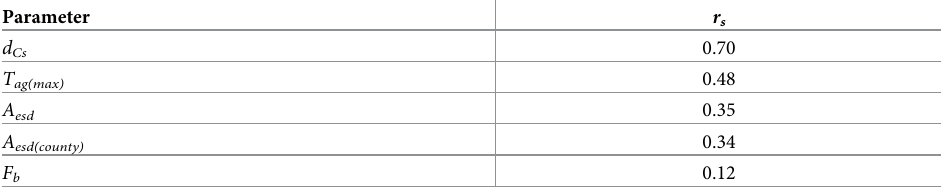
Table 6. Spearman rank correlation coefficient, r s , for CED(50) . Only parameters with a correlation coefficient greater than 0.1 are given. Parameter